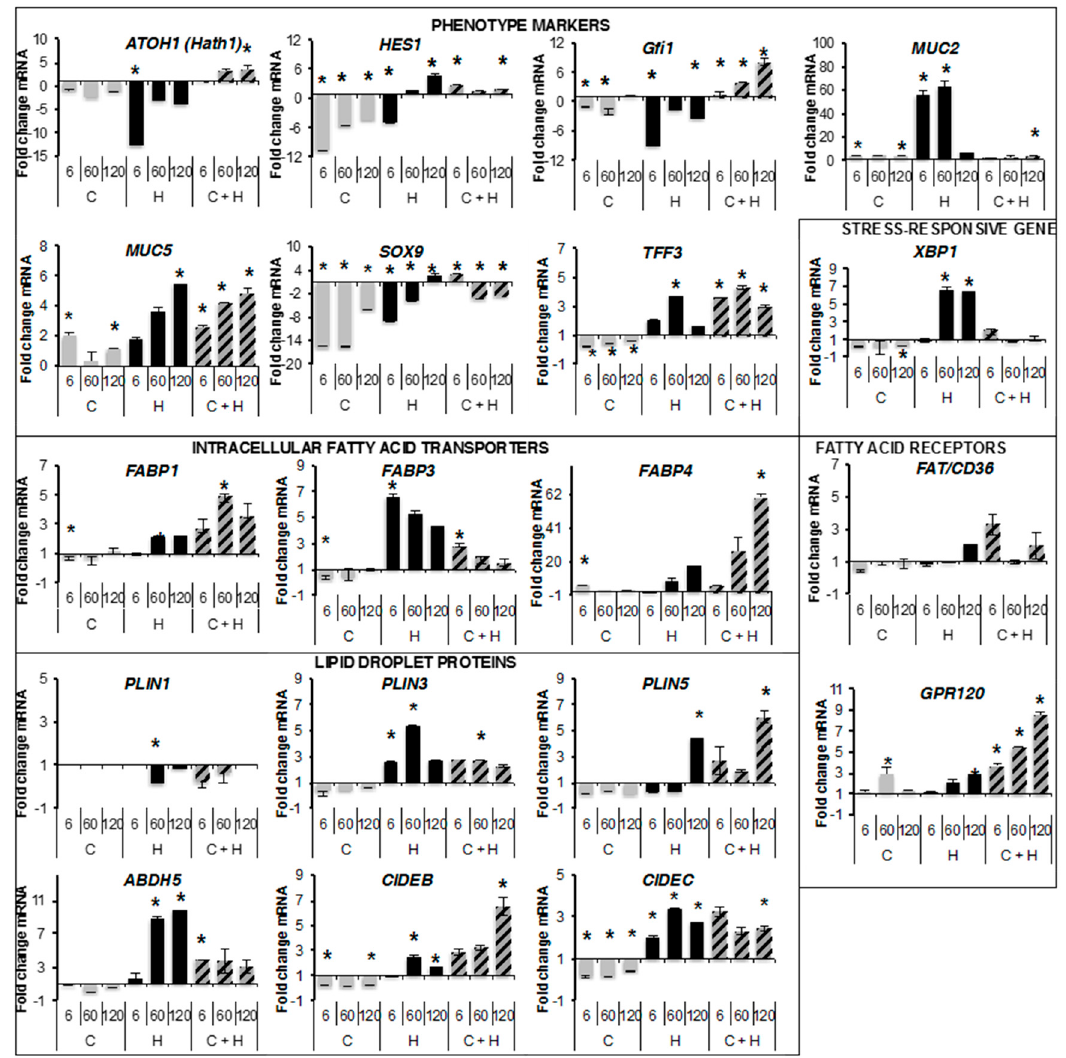
Figure 7. Transcriptional regulations by oleic acid in Caco-2 (C), HT29-MTX (H) and co-cultures (C + H). Fully differentiated cultures (Day 18) were treated for 48 h with several doses of oleic acid complexed to bovine serum albumin (representative experiment). mRNA quantifications are presented as fold changes of treated versus control samples normalized to those of HPRT and measured in triplicates on cumulated 8 wells from 96-wells plates. Data are presented as mean values ± SD and significant Student t -test p -values < 0.05 are indicated by stars.